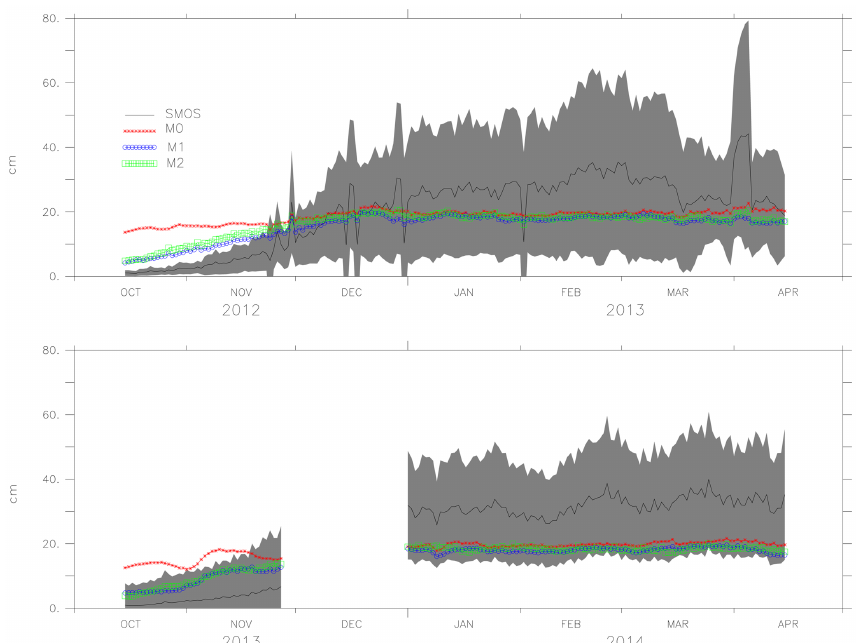
Figure 11. The ice thickness from the models M0, M1, M2 and observation (SMOS ice thickness) and the observation uncertainty (shaded grey) for SMOS ice thickness less than 30cm